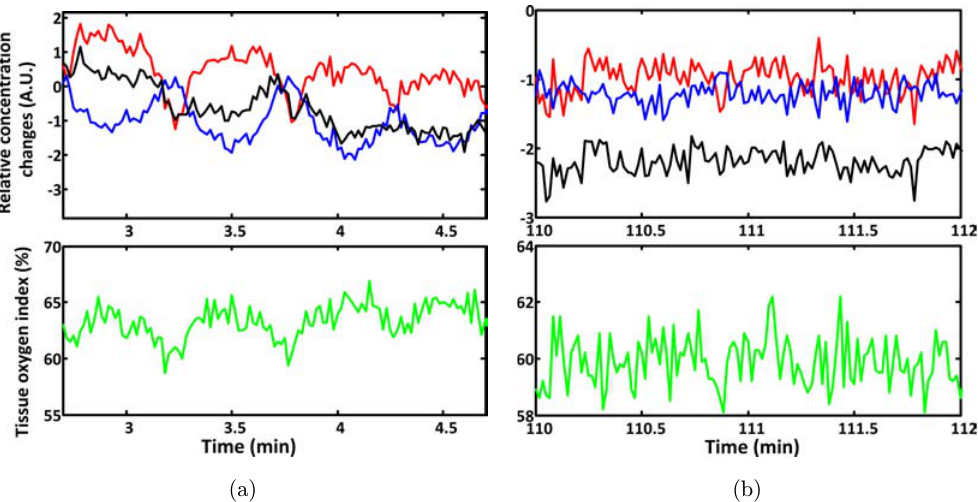
Fig. 2. Typical fragments of cerebral hemodynamics during baseline measurements (a) and optimal CPAP pressures (b) measured from Subject 2. The captions are the same as shown in Fig.